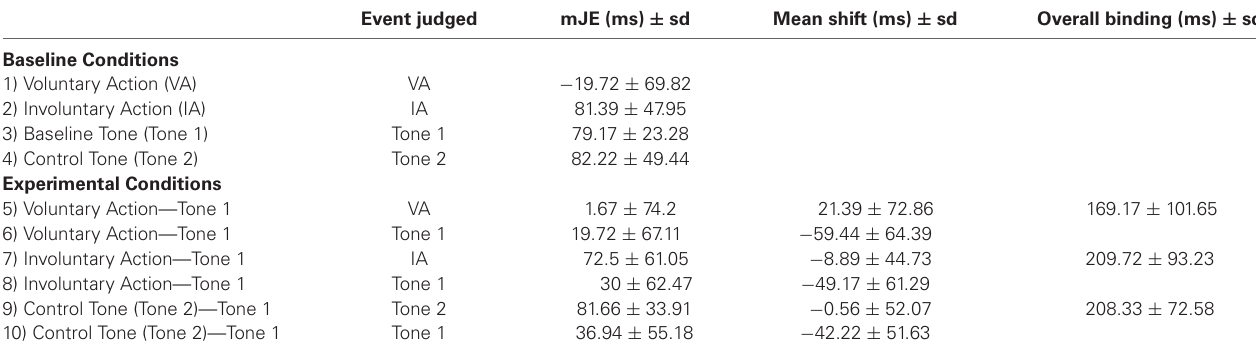
Table 3 | mJEs, perceptual shifts and overall binding in children (Experiment II) .